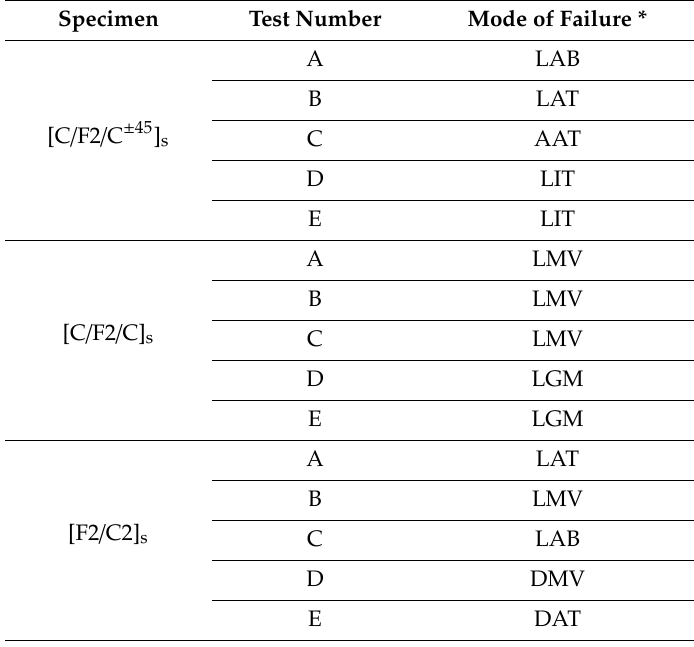
Figure 6. Optical images of the damaged features for various composites studied. [F / C3] s showing edge delamination and stress concentrations at failure points ( a , b ), as well as some signs of voids and fibres pull out ( c ); fracture in [C / F2 / C ± 45 ] s samples ( d , e ), flax fibres extrusion in ( f , g ) and [C / F2 / C] s laminate ( h ) fracture and delamination. Table 3. Tensile test failure analysis of the composite